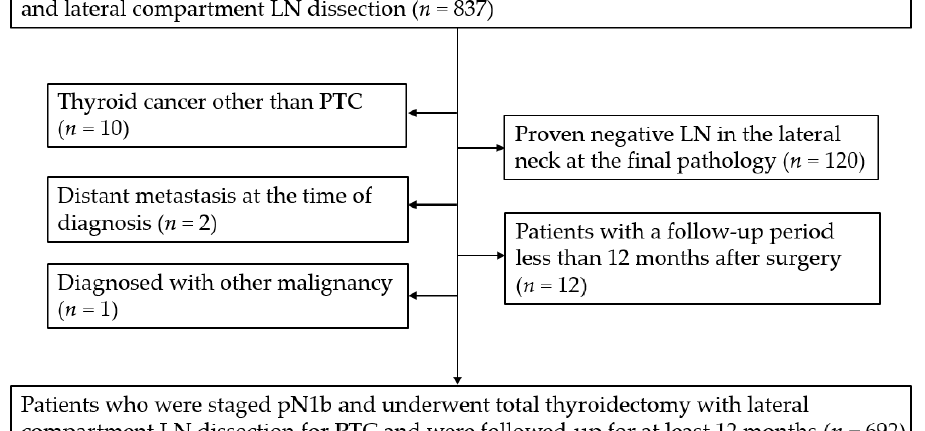
Figure 1. Flowchart of the study population. US, ultrasound; LN, lymph node; PTC, papillary thyroid carcinoma.